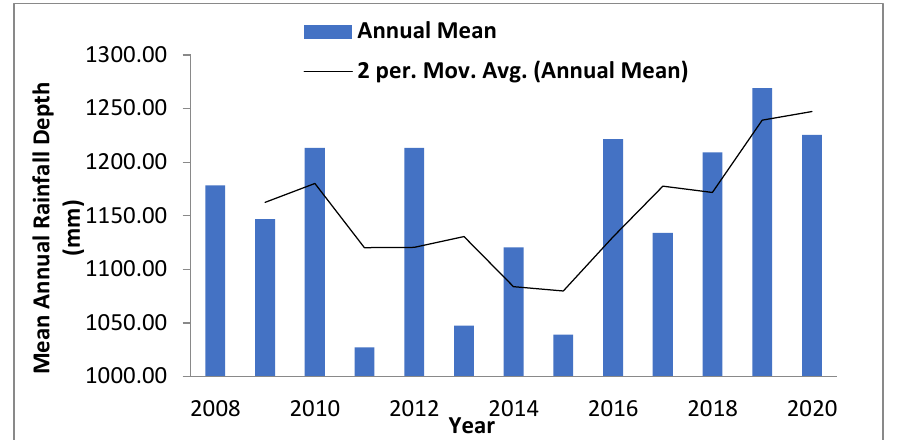
Figure 3. Mean yearly rainfall depths of study location.